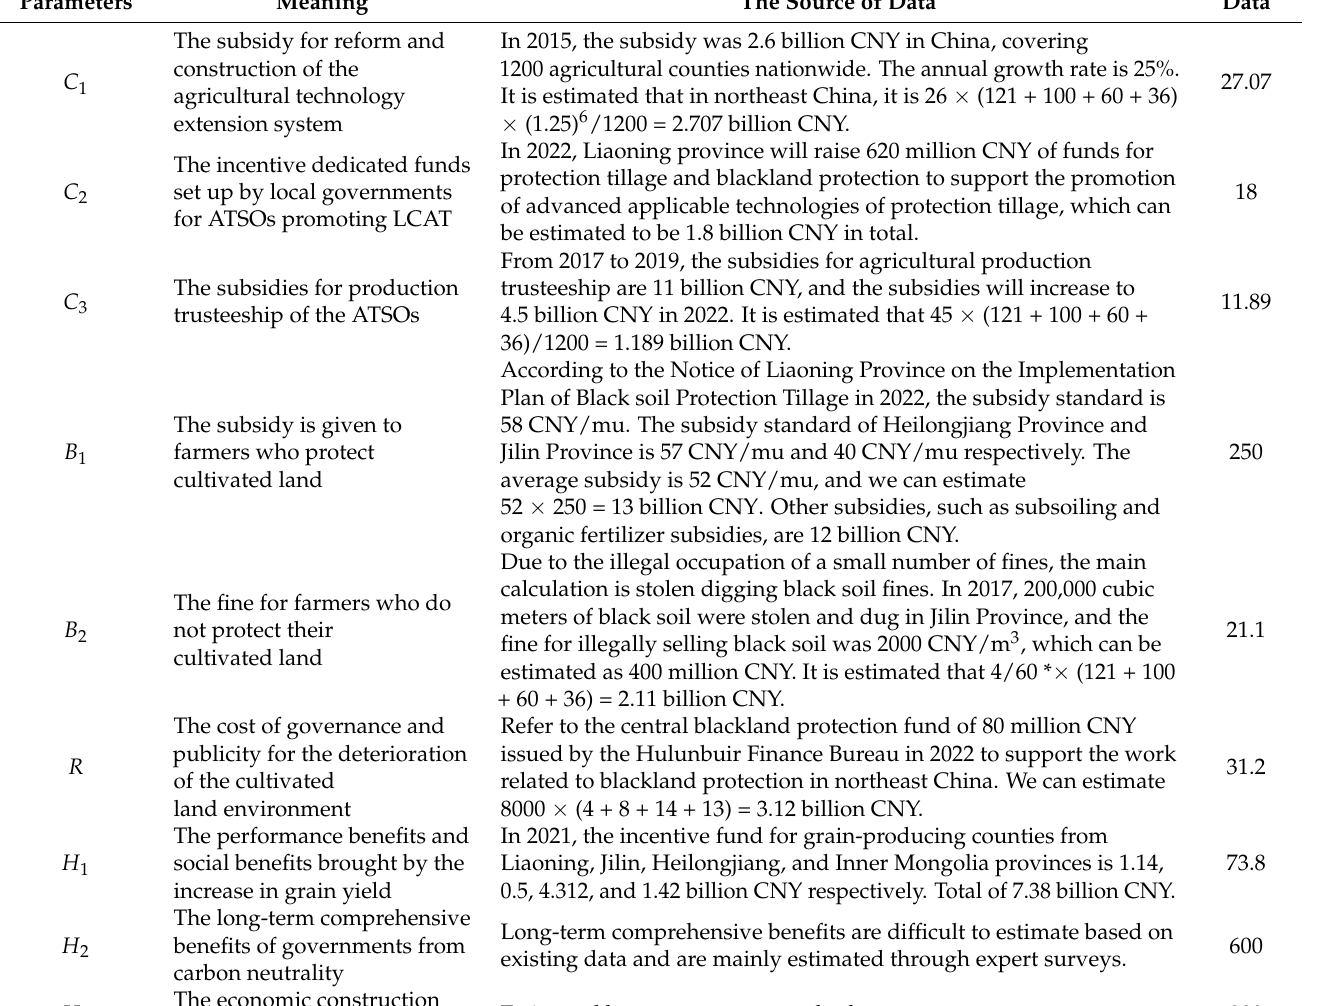
Table A1. Initial assignment of the variable parameters based on real